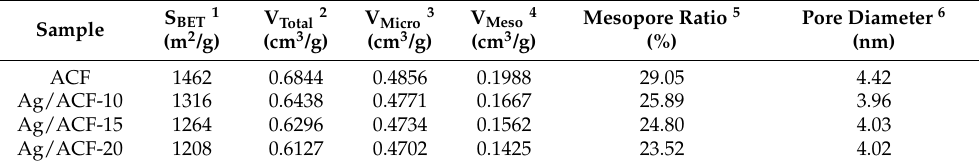
Table 2. Textural properties of ACF and Ag/ACF composites.